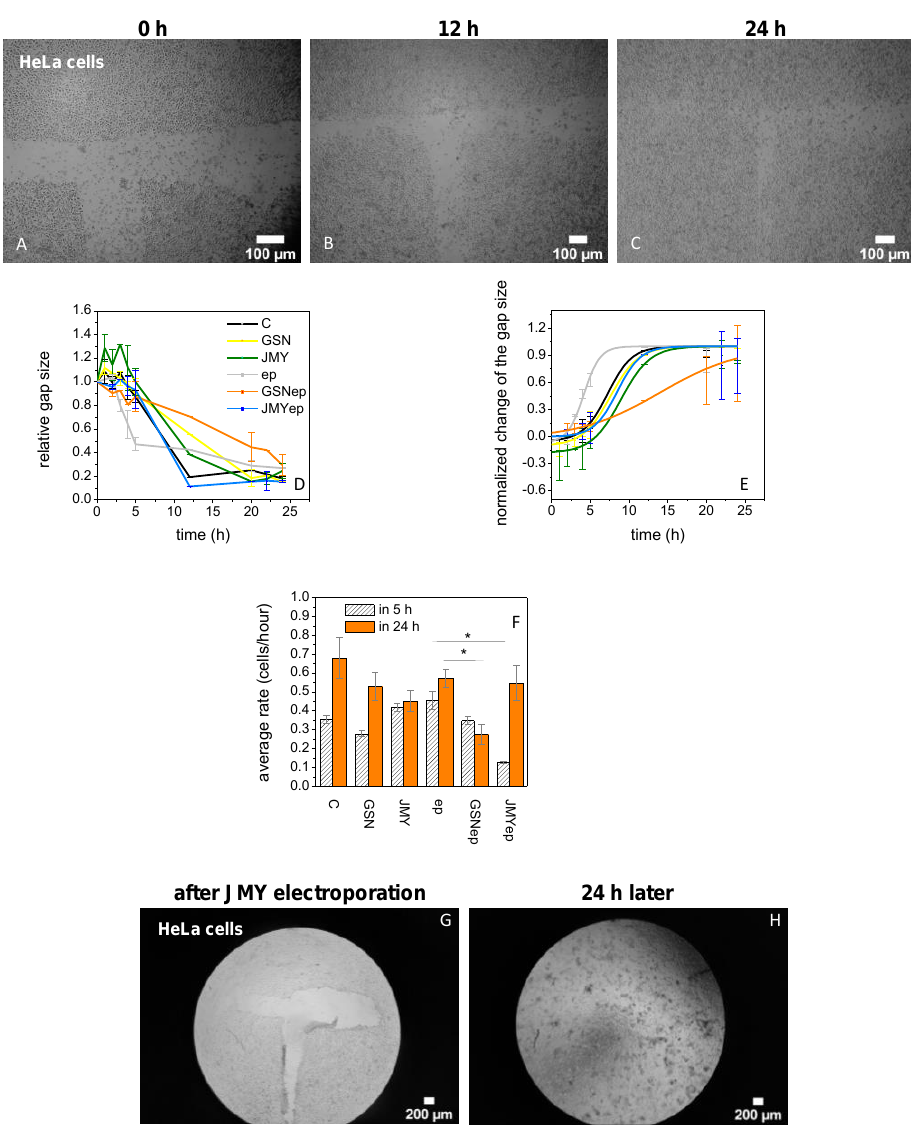
Figure 5. GSN and JMY affect the division and motility of HeLa cells. ( a – c ) Scratching assays to examine the rate of gap size recovery after GSN or JMY electroporation. In the first 24 h after scratching a ’ T ’ shape in HeLa cells, the cultures were examined to investigate the effect of GSN or JMY electroporation. ( d ) The assays provided data about the effect on the change of the relative gap size by simple addition of buffer only (black line), 125 nM GSN (yellow line), 125 nM JMY (green line) to the cell culture or electroporation with buffer only (gray line), with 125 nM GSN (orange line), or with 125 nM JMY (blue line). ( e ) The normalized change of the gap size gives information about the cellular motility changes in the first 5 h and the division rate at 12 and 24 h. The time-dependent recovery of the scratch is related to the initial size of the gap and the size of the cells. These parameters were used to normalize previous data. The electroporation with GSN shows a different slope of the sigmoid graph. ( f ) For the analysis of the cellular motility and divi- sion rates in cells/hour, we used the normalized values in the first 5 h and 24 h, respectively. The comparison of recovery rates resulted that the electroporation stimulated the cells which were moving faster than non-electroporated cells in the first 5 h. After the electroporation with JMY, the motility of cells was slowed down (* p < 0.05), after they divided faster than electroporated control cells. Due to the electroporation with GSN, cells were moving normally but dividing slowly ( p < 0.05). ( g – h ) HeLa cells recovered the gap fully 20 h after the electroporation with JMY then started to release from the glass slides to the solution. The data presented were derived from at least three independent experiments. Values are displayed as the mean ± standard deviation. 3. Discussion